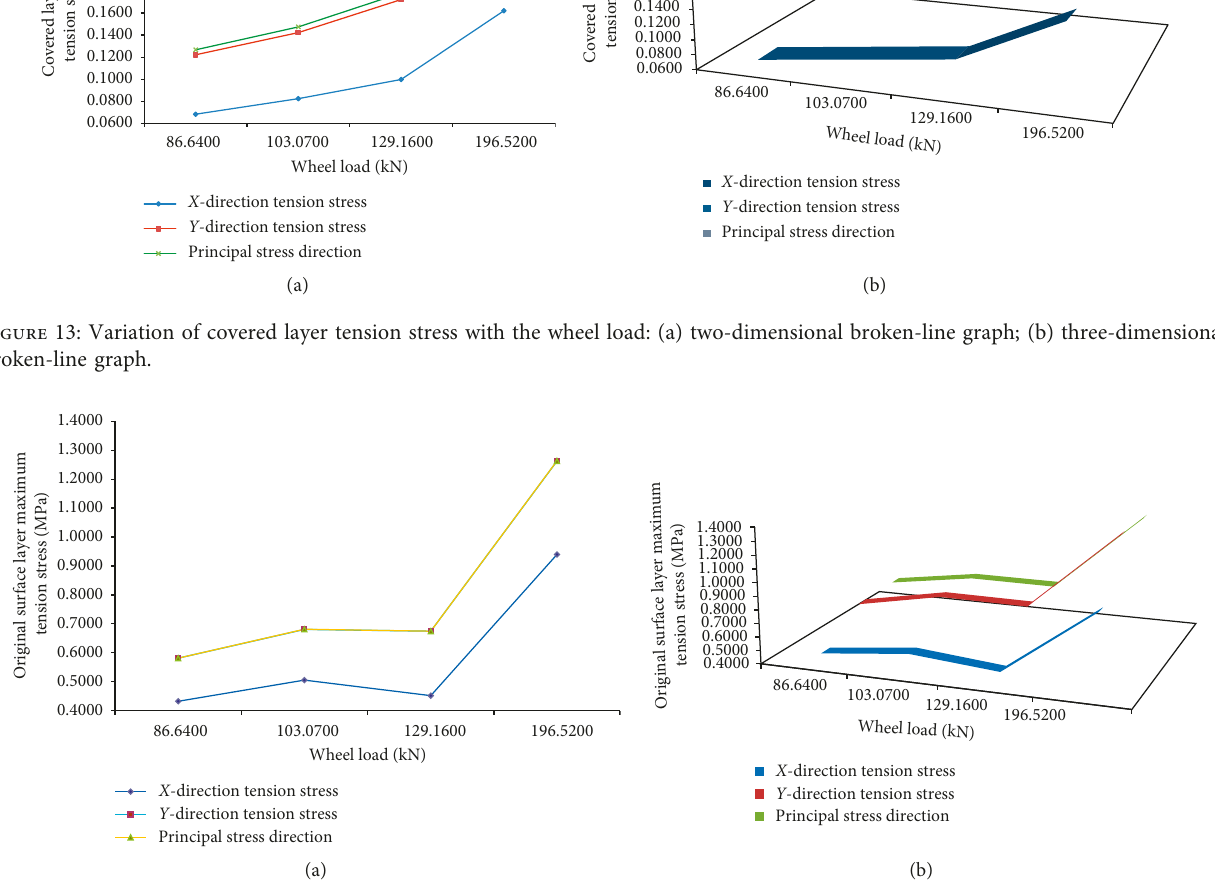
Figure 14: Variation of original surface layer tension stress with wheel load: (a) two-dimensional broken-line graph; (b) three-dimensional broken-line